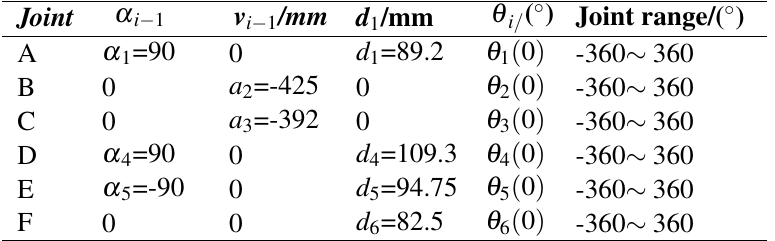
Table 1 D-H parameters of UR5 robotic